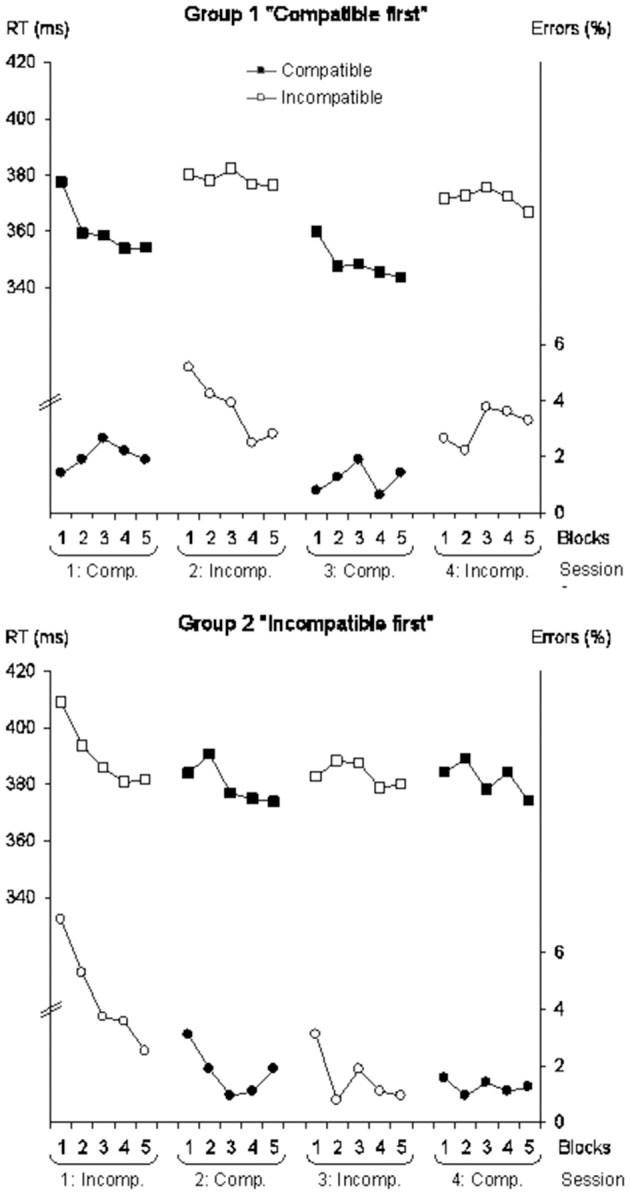
Mean reaction time (in ms, upper part of each graphic, squares) and mean side error percentage (lower part, circles) for the group 1 practicing the compatible mapping first (“Compatible first,” top) and the group 2 practicing the incompatible mapping first (“Incompatible first,” bottom) as a function of block of trials, session, and mapping (compatible mapping: Comp., filled symbols; incompatible mapping: Incomp., empty symbols).